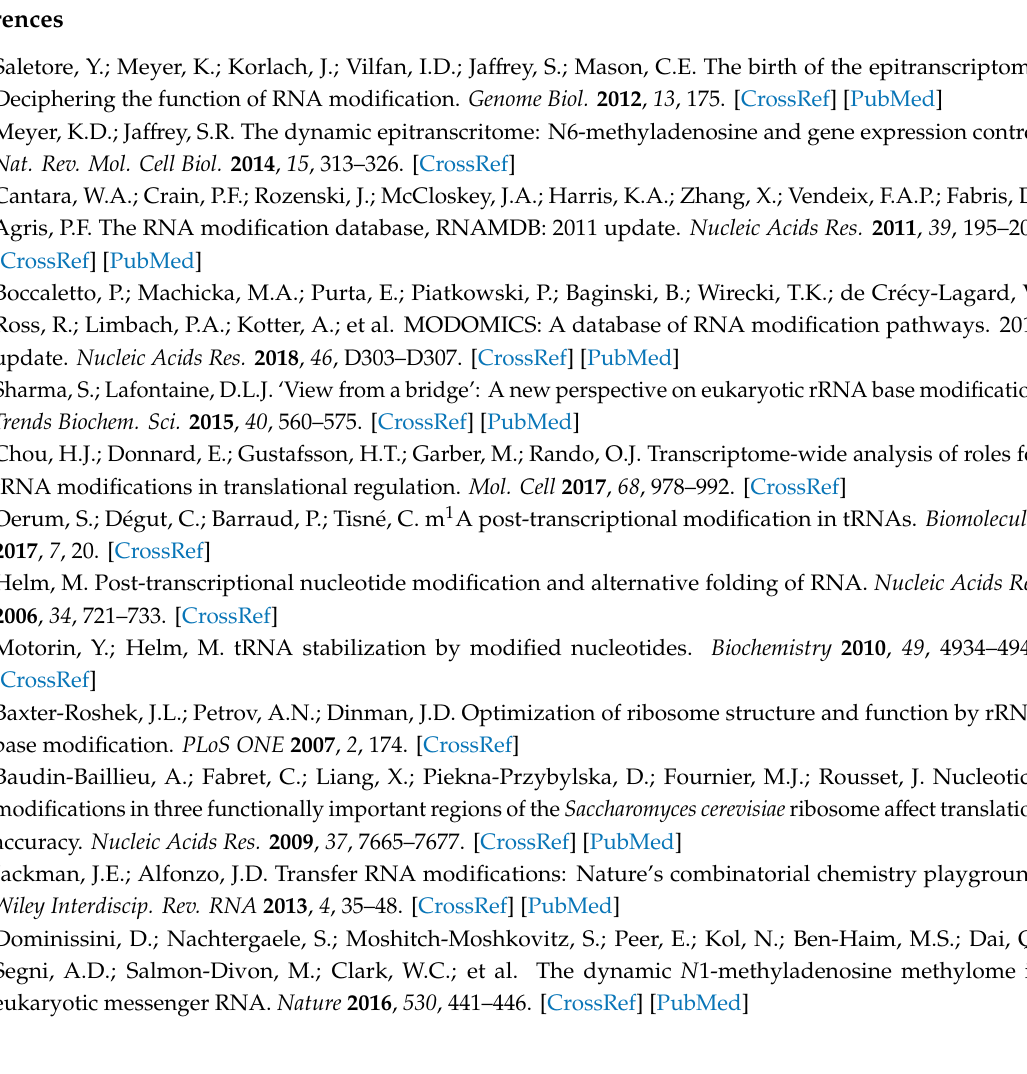
s1. Figure S1: Domain structures of the ALKB domain-containing proteins in Arabidopsis ; Figure S2: The expression patterns of the stress-responsive marker genes in Arabidopsis ; Figure S3: Confirmation of the T-DNA insertion alkbh6 mutants; Figure S4: Seed germination of the alkbh6 mutants under normal and abiotic stress conditions; Figure S5: Phenotypes of the alkbh6 mutants under normal growth conditions; Figure S6: Drought sensitivity of the alkbh6 mutants; Figure S7: Levels of m6A / A and m5C in the alkbh6 mutants; Figure S8: Purification of the recombinant ALKBH6 protein; Table S1: Gene-specific primer pairs used in this